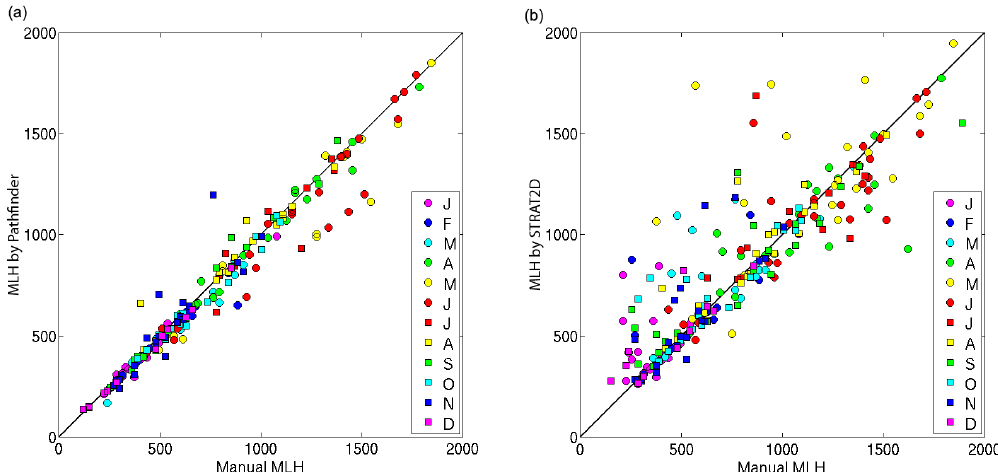
Figure 11. Scatter plots of (a) pathfinder MLH L,P against MLH M ( R 2 = 0 . 96) and (b) STRAT2D MLH L,S against MLH M ( R 2 = 0 . 74) for the full data set of 2010. Colour coding indicates the month of the